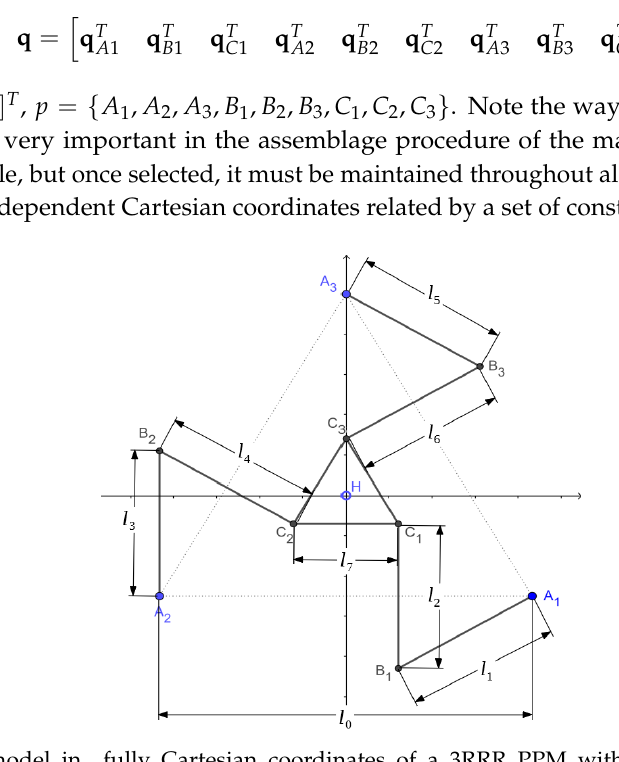
Figure 3. A model in fully Cartesian coordinates of a 3RRR PPM with nine “basic points”: A 1 , A 2 , A 3 , B 1 , B 2 , B 3 , C 1 , C 2 , and C 3 . Points A 1 , A 2 , and A 3 are fixed. Point H represents the end-effector and is not part of the ”basic